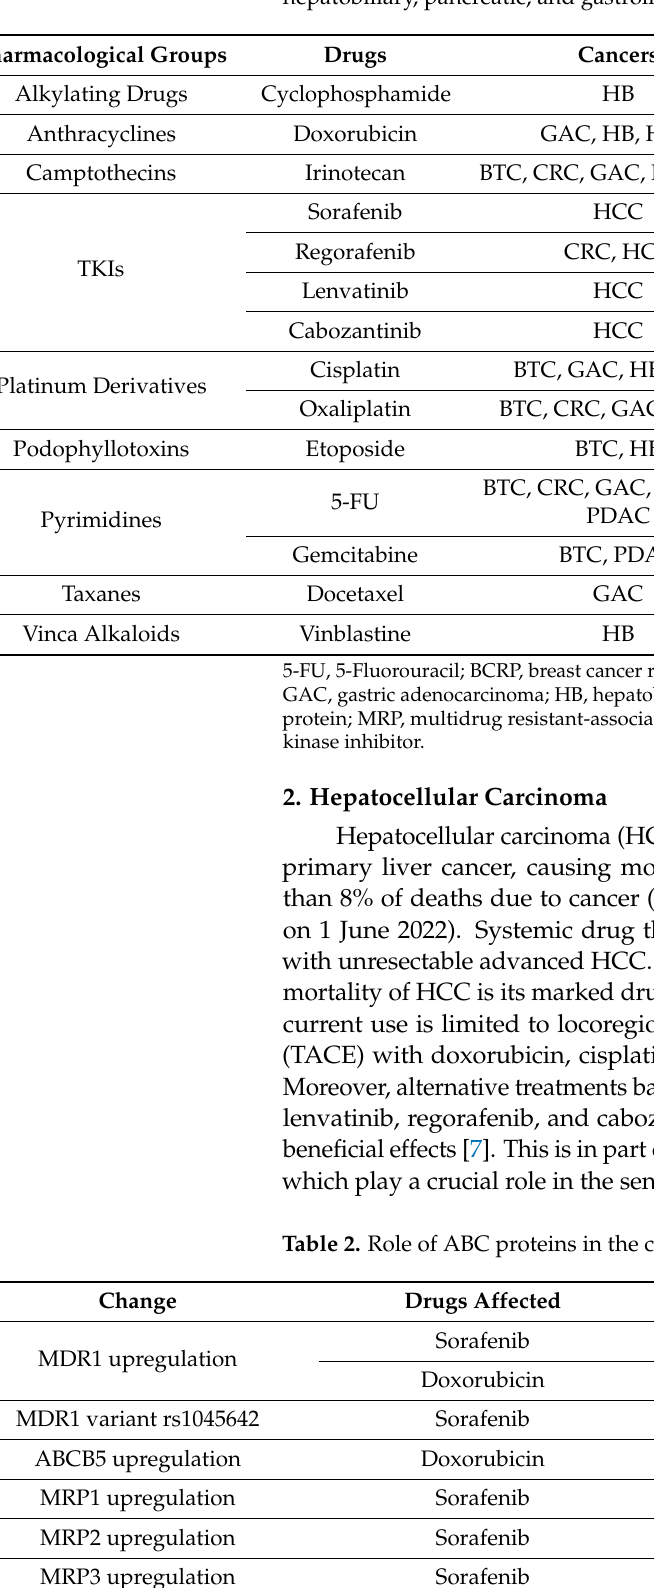
Table 1. ABC proteins involved in the transport of common antitumor drugs used in the treatment of hepatobiliary, pancreatic, and gastrointestinal tumors.